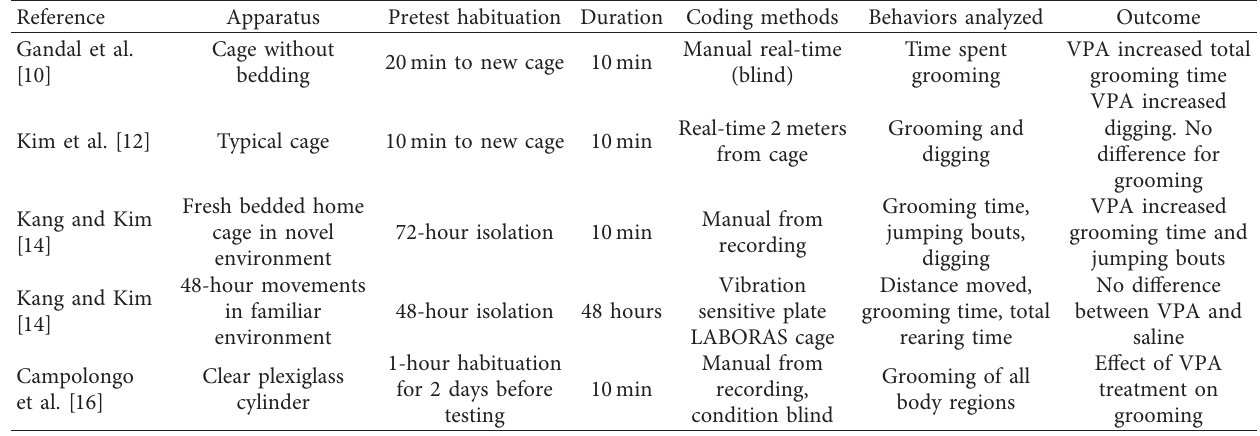
Table 4: Repetitive behavior in open environments.